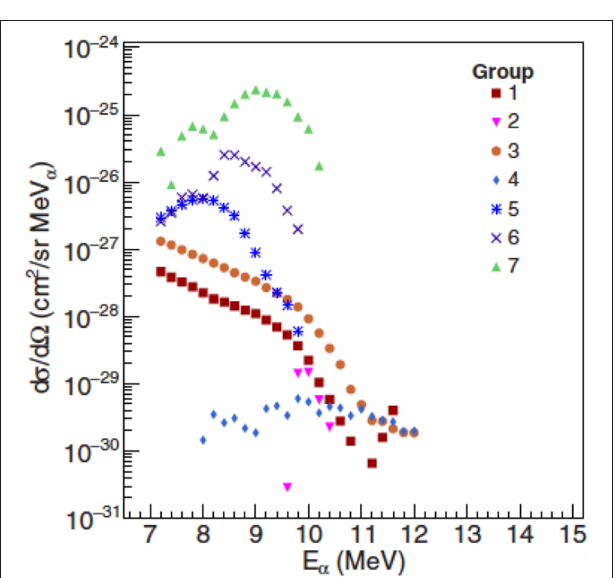
FIGURE 3 | A plot of the differential cross section of TLF events in the angular range from 31 to 51 ◦ for the reaction of 238 U with 232 Th. Groups 1-7 correspond to various half-life ranges with Group 1 corresponding to the shortest half-lives and Group 7 the longest half-lives.